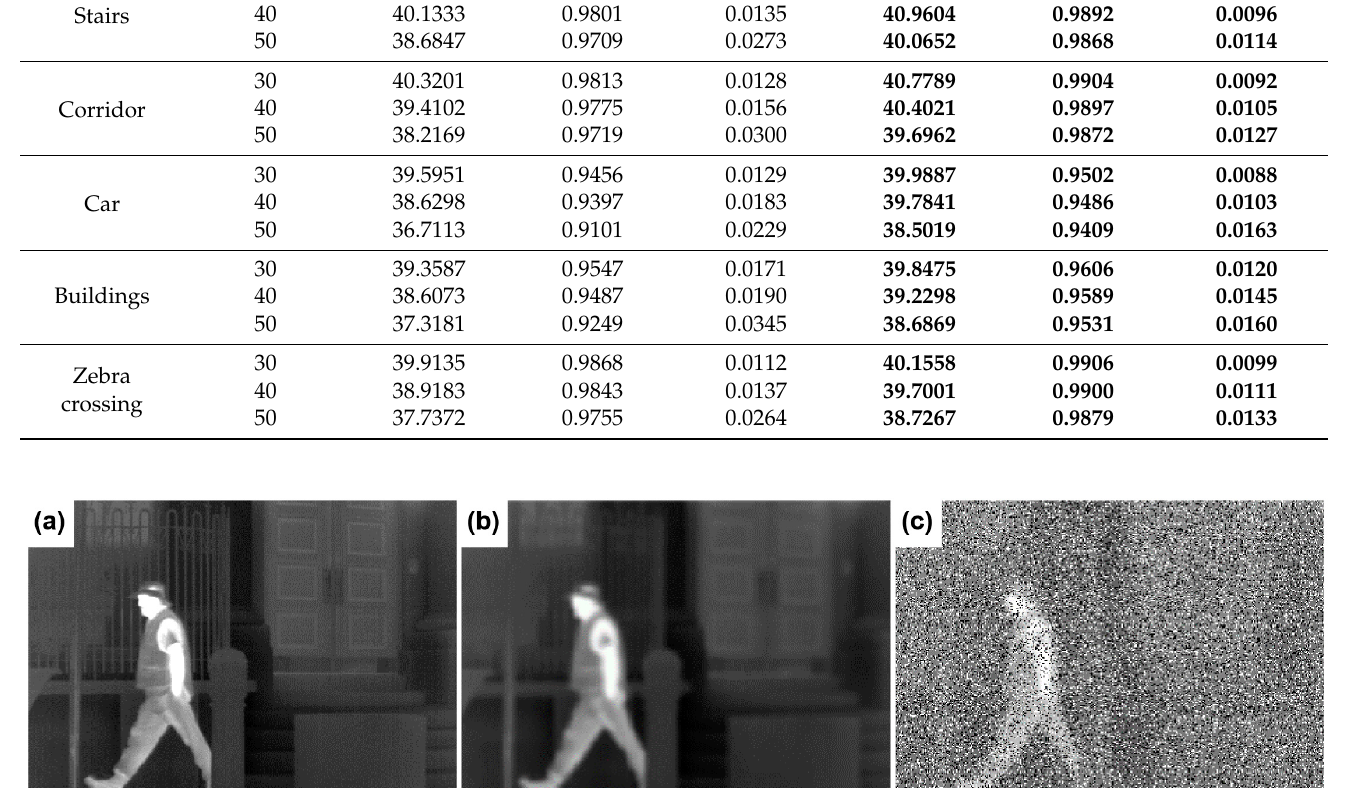
Figure 3. A comparison of the deblurring effects on a passerby image. ( a ) The original passerby image, ( b ) the image deblurred using Lp_LOGS, and ( c ) the image deblurred using Lp_HOGS. ( d – f ) The local enlarged images from the red boxes in ( a – c ), respectively. A comparison of Figure 2a,c with Figure 3b,c revealed that the image deblurred by Lp_LOGS had more speckle noise than the one deblurred by Lp_HOGS. The images in the red boxes in Figure 3b,c were enlarged to further visualize the difference between the two and the results are displayed in Figure 3e,f, respectively. The right half was a largely smooth area in Figure 3e,f. Figure 3f had less salt-and- pepper noise compared with Figure 3e and its visual effect was closer to that of the origi- nal image. The left half was mostly the edge area, therefore it was difficult to see the de- noising effect. However, Figure 3f retained more details. For example, the lines of the iron fence are clearer and more continuous. Overall, the visual effect of Figure 3f was closer to that of the original image, indicating that the deblurring performance of Lp_HOGS under